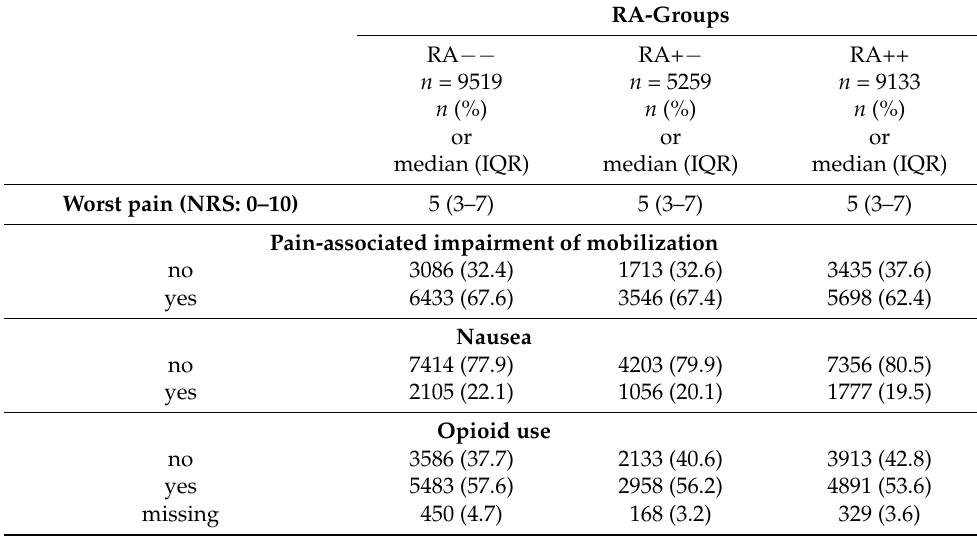
Table 2. Outcome statistics per regional anesthesia